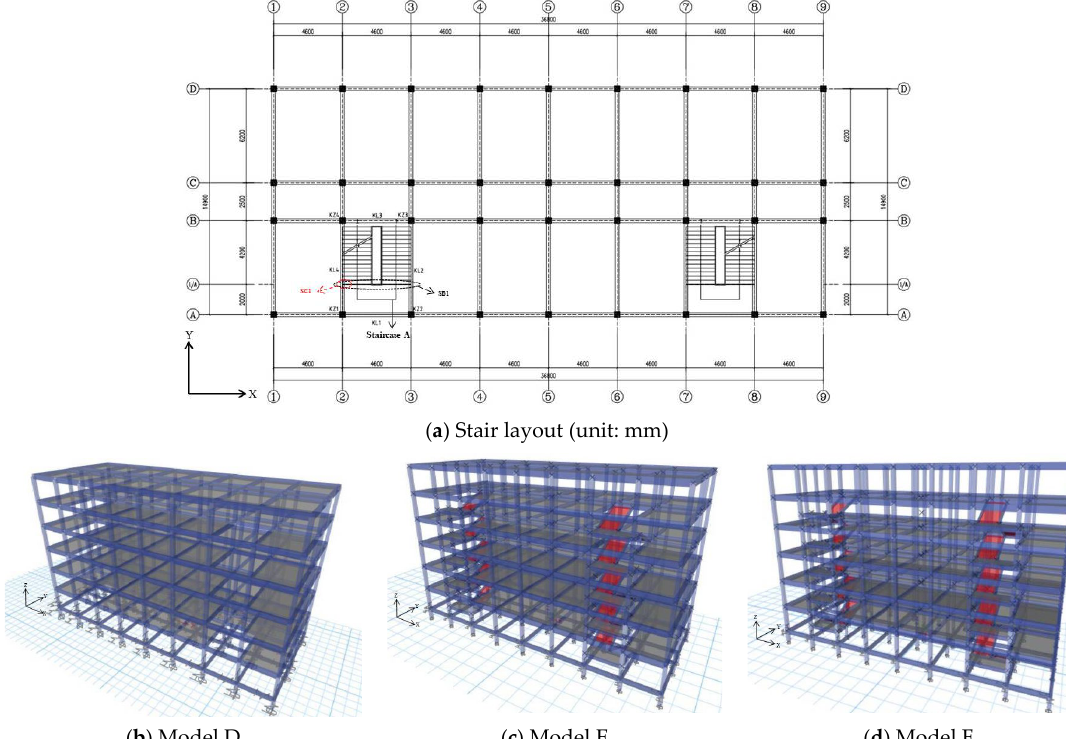
Figure 5. The three ETABS